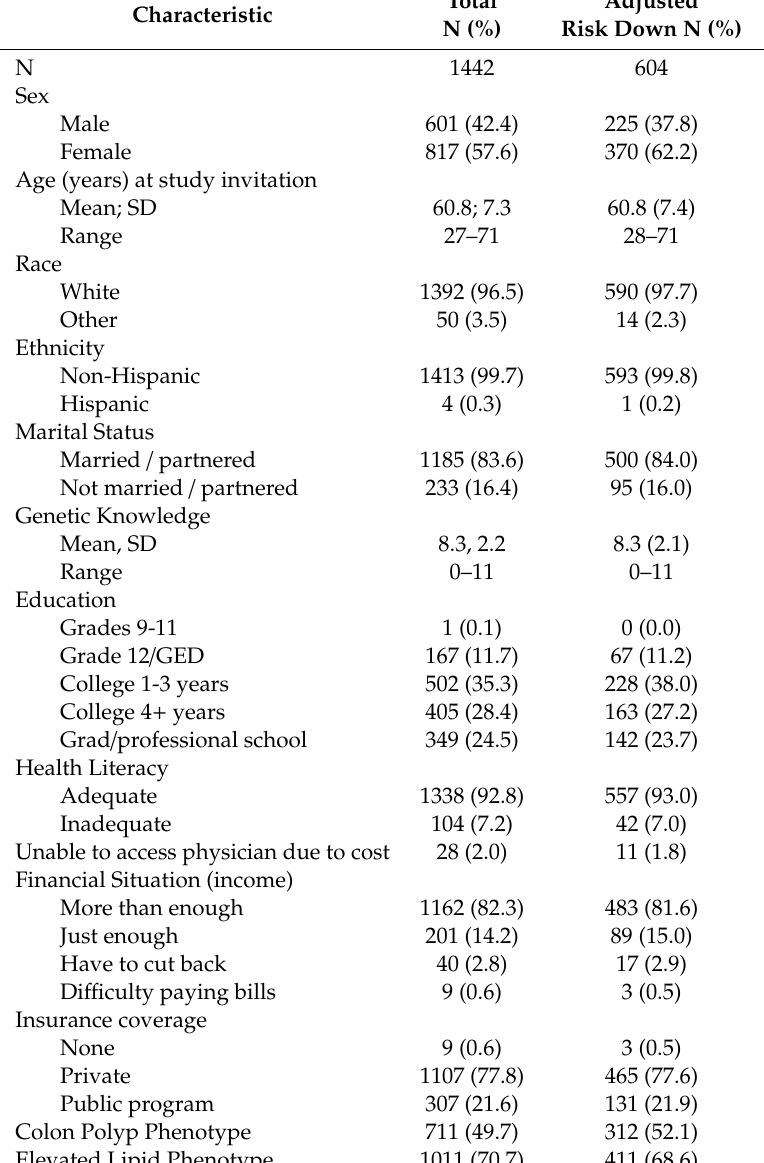
Table 1. Demographic characteristics of participants who pursued genomic screening ( n = 1442) and those who adjusted their risk down after receiving negative results.